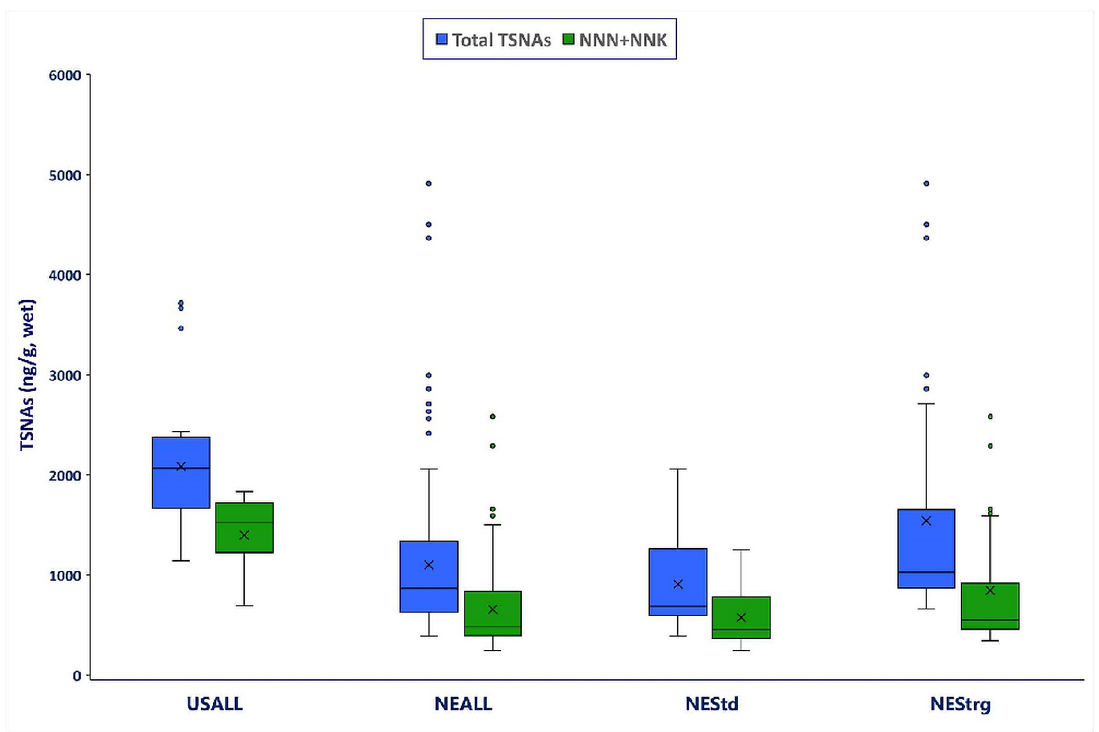
Fig 3. Total TSNAs and carcinogenic TSNA (NNN+NNK) concentrations (mg/g, wet weight) for US snus (USALL), Northern Europe snus (NEALL), NE snus with “standard” descriptors (NEStd) and NE snus with “strong” descriptors (NEStrg). Note: USALL (n = 8: all 8 portion); NEALL (n = 56: 7 loose and 49 portion); NEStd. (n = 39: 6 loose and 33 portion); NEStrg (n = 17: 1 loose and 16 portion).